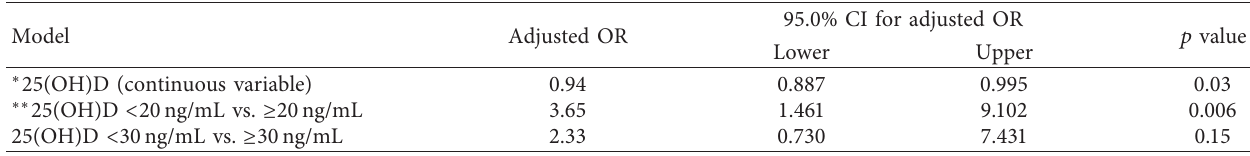
Table 3: Models derived with multivariate logistic regression analysis of associated factors of DHF/DSS.